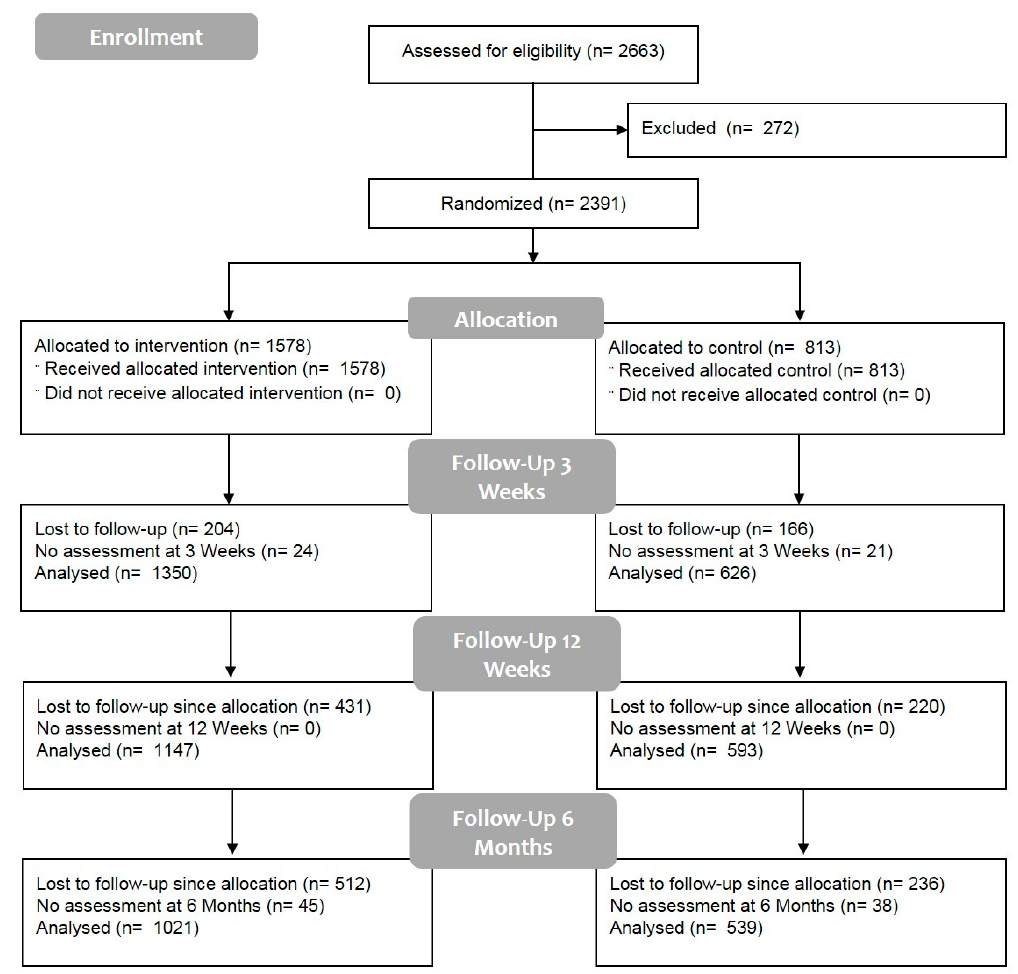
Figure 1. Participants’ flow.